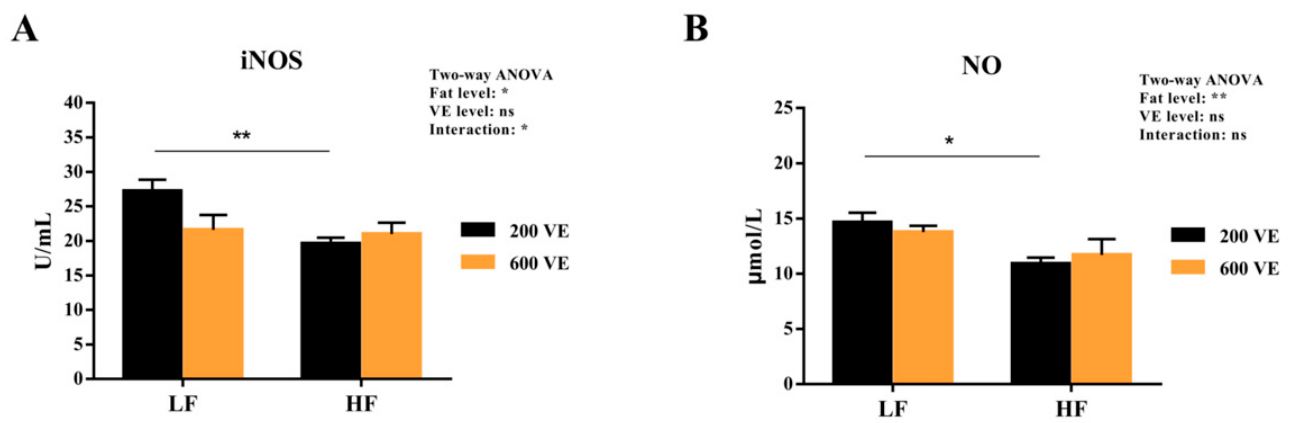
Figure 6. Hemolymph iNOS activity and NO content of Macrobrachium rosenbergii fed with different dietary fat and VE levels . ( A ) hemolymph inducible nitric oxide synthase (iNOS) activity of M. rosenbergii fed with different dietary fat and VE levels; ( B ) hemolymph nitric oxide (NO) content of M. rosenbergii fed with different dietary fat and VE levels. Values are means ± SEM. ***: p < 0.001, **: p < 0.01, *: p < 0.05, ns: p < 0.05.